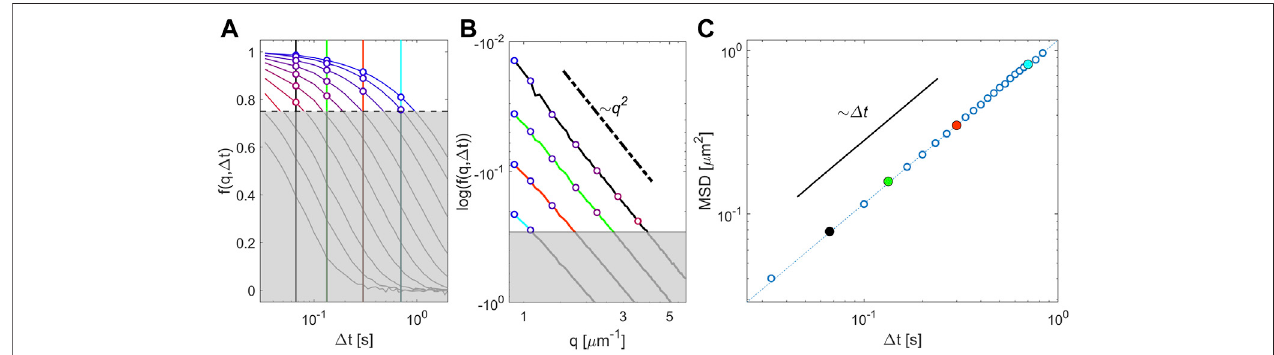
FIGURE 1 | Model-free determination of the mean square displacement and non-Gaussian parameter with ConDDM. (A) Representative normalized ISFs as a functionofthedelaytime Δ t fordifferentvaluesofthemagnitudeofthewavevector q (increasingfrombluetored).Thegrayshadedareamarkstheregionlyingbelowthe threshold value of 0.75 of the ISFs that we considered for the determination of the MSD. Large circles correspond to the allowed q values, which are found as the intersectionoftheISFsandsomerepresentativedelaytimes Δ t (coloredverticallines)togetherwiththeconditiononthemaximumrelaxation. (B) Log – logplotofthe ISFsasafunctionofthemagnitudeofthewavevectorforthesamerepresentativedelaytimes Δ t ofthepanel (A) . (C) MSDestimatedforeachdelaytimeasthebest fi tto thelogarithmoftheself-ISFslog( f self ( q , Δ t ))with Eq.3 .Largecirclescorrespondto Δ t shownwiththesamecolorsinpanels (A) and (B) .Therepresentativedatashownin this fi gure have been obtained on a diluted ( φ s < 0.001) suspension of colloidal particles of diameter σ = 0.56 µm, as described in the main text.